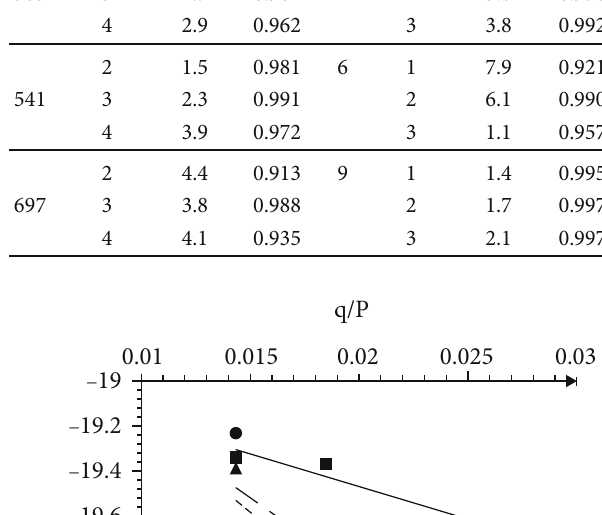
q / P for microwave-assisted air